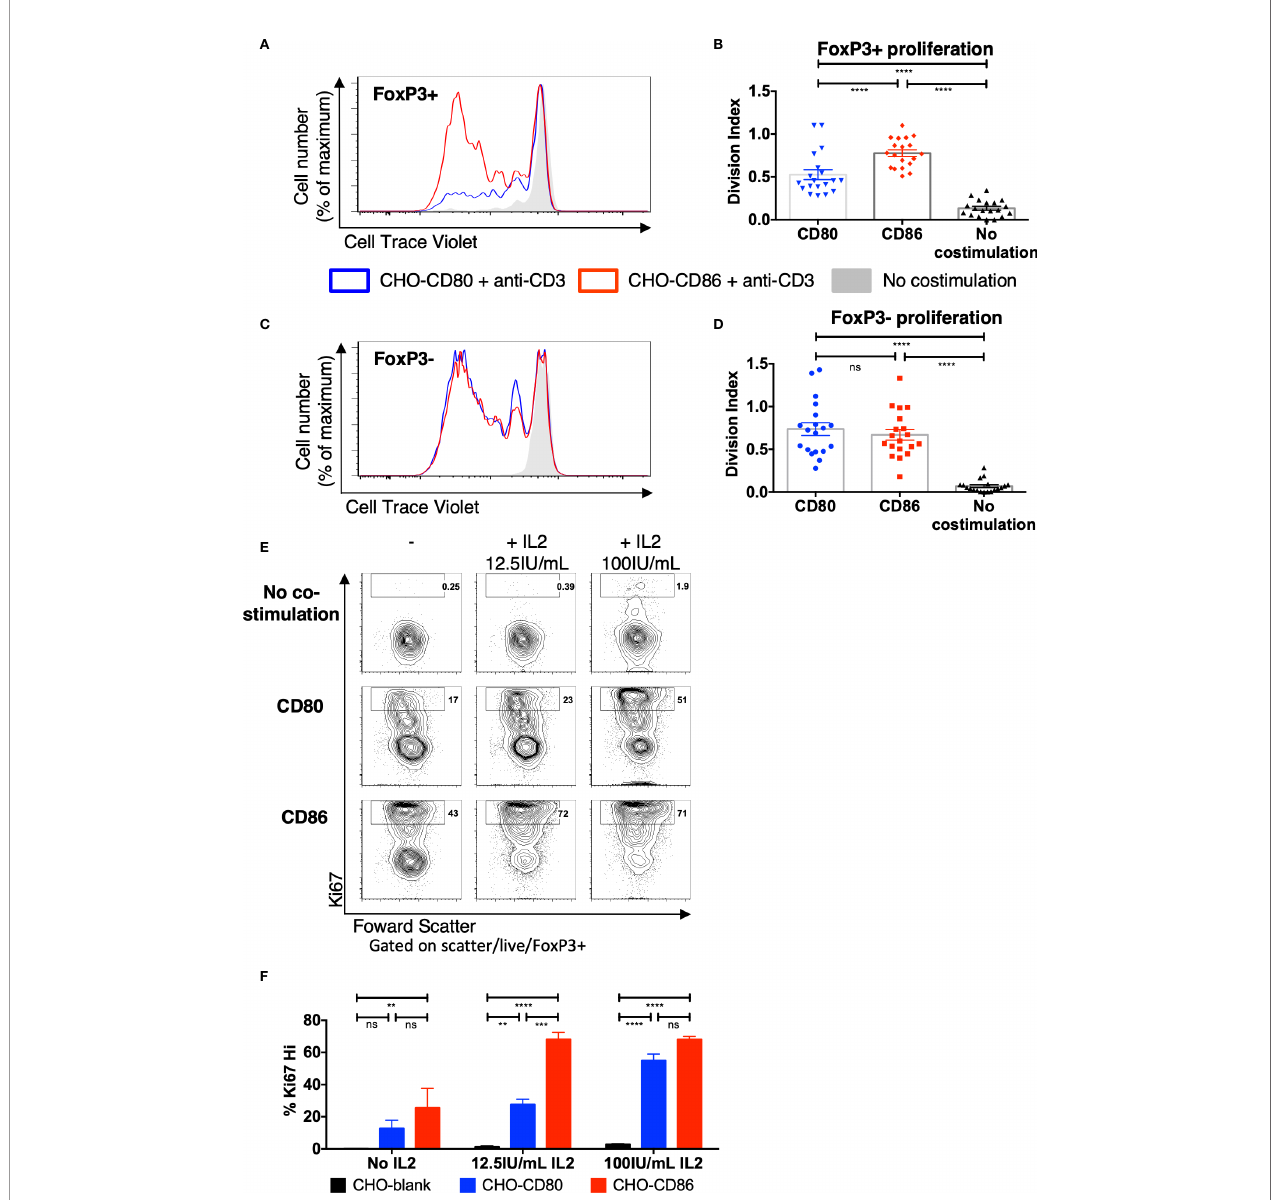
FIGURE 1 | Treg selectively proliferate in response to CD86 costimulation. (A – D) CTV labelled total memory CD4 T cells isolated from healthy donors were cultured for 5 days with CHO-CD80, CHO-CD86, or untransduced CHO (no costimulation), at a ratio of 10 T cells to one CHO cell, with 0.5 m g/ml anti-human-CD3. (A) representative proliferation traces and (B) division indices of FoxP3+ T cells are shown. (C) proliferation traces and (D) division indices of FoxP3- conventional memory CD4 T cells (19 independent experiments). (E , F) puri fi ed Treg isolated from healthy donors were cultured with CHO-CD80, CHO-CD86, or untransduced CHO cells, at 10:1 ratio for 5 days, with 0.5 m g/ml anti-human-CD3 with increasing additional IL2. (E) representative Treg Ki67 expression. (F) percentage of Ki76+ Treg after 5 days (three independent experiments). Statistical signi fi cance of Tukey ’ s multiple comparisons tests: ns p>0.05, **p ≤ 0.01, ***p ≤ 0.001, ****p ≤ 0.0001 using One-way analysis of variance (ANOVA) (B , D) and two-way ANOVA (F)